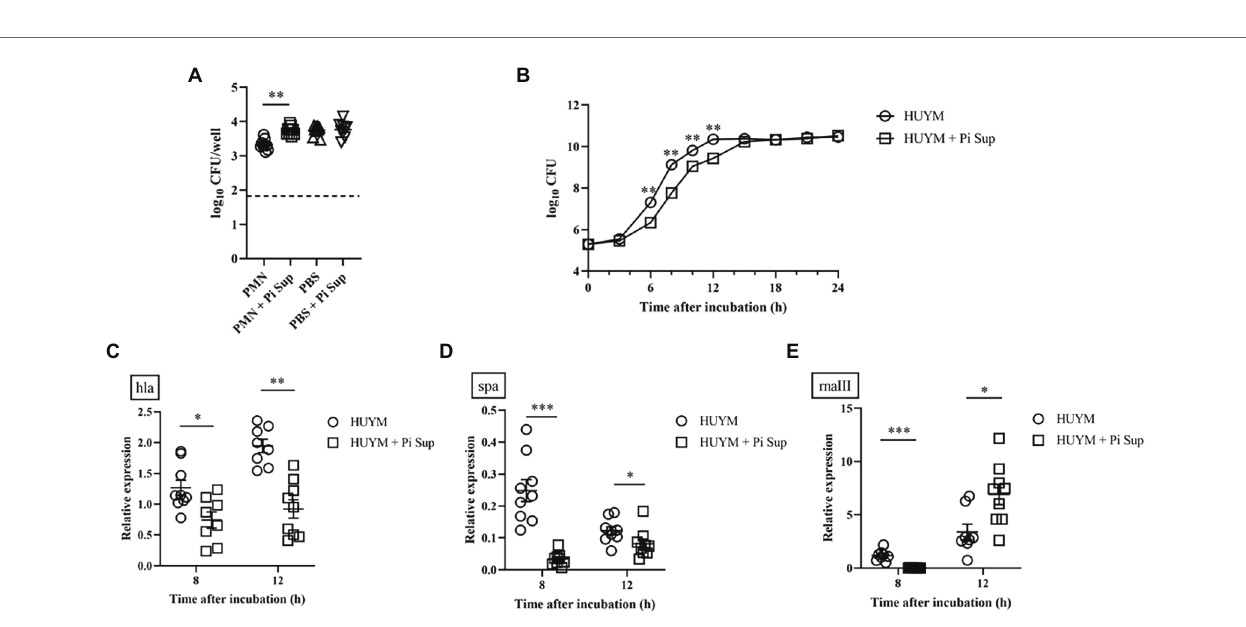
FIGURE 2 | Transcript levels of (A) hla, (B) spa, and (C) rnaIII measured 16 h after inoculation in mice infected with the HUYM MRSA strain with/without Pi Sup. *** p < 0.001; n.s., not significant; Bars represent the mean relative messenger RNA (mRNA) expression. Data are representative of 6–8 mice from two independent